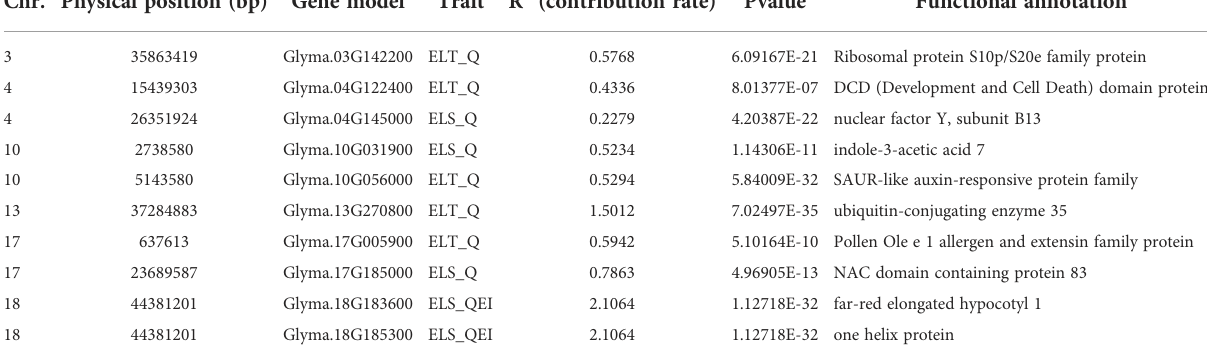
TABLE 1 Gene based association of candidate